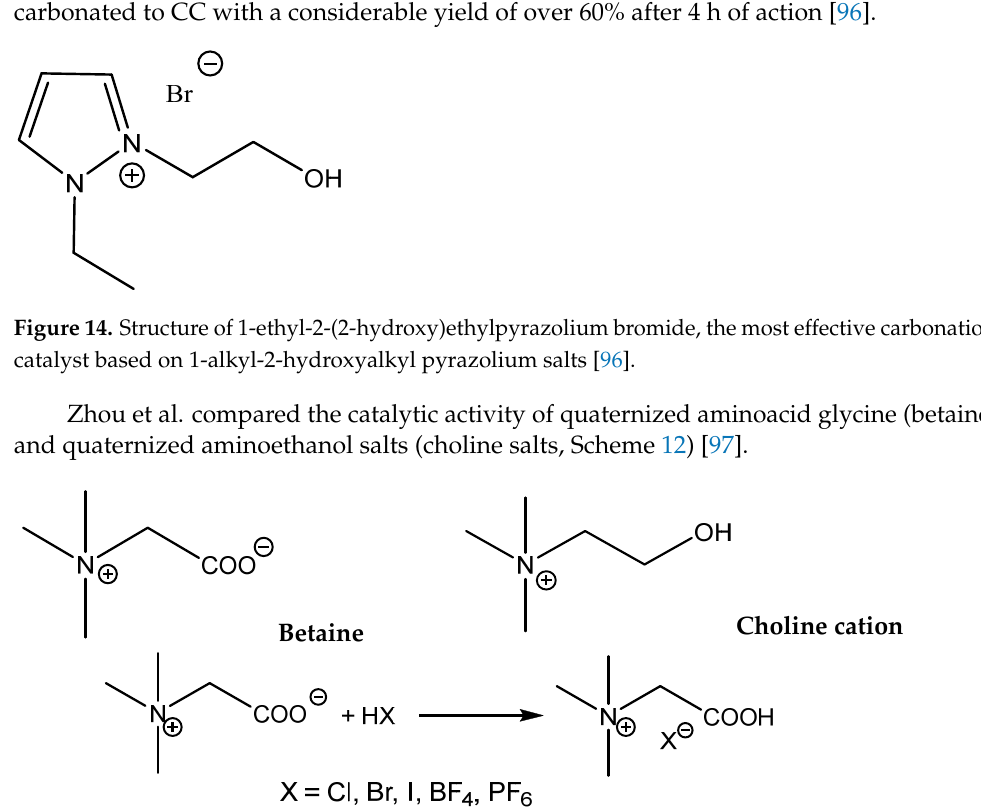
Scheme 12. Structures of tested bifunctional onium salts and scheme of preparation of betaine hy- drohalides